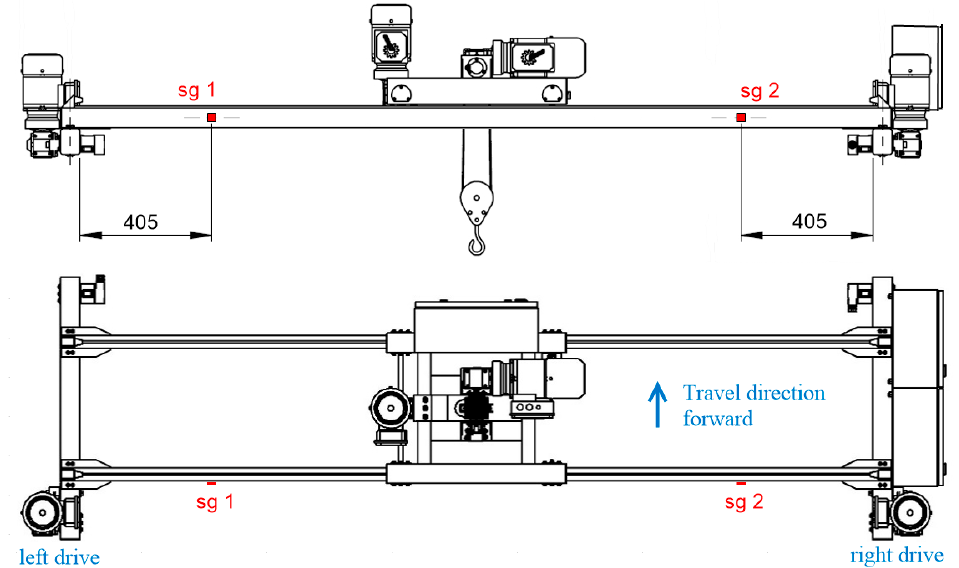
Figure 5. Placement of the strain gauge sensors on the crane bridge construction.